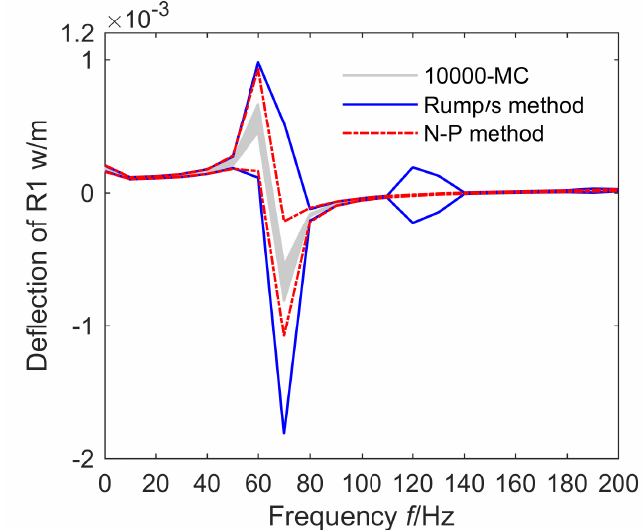
Figure 15. The conservativeness comparison of sound pressure at the point of R1 by Rump’s method and Neumaier–Pownuk method.